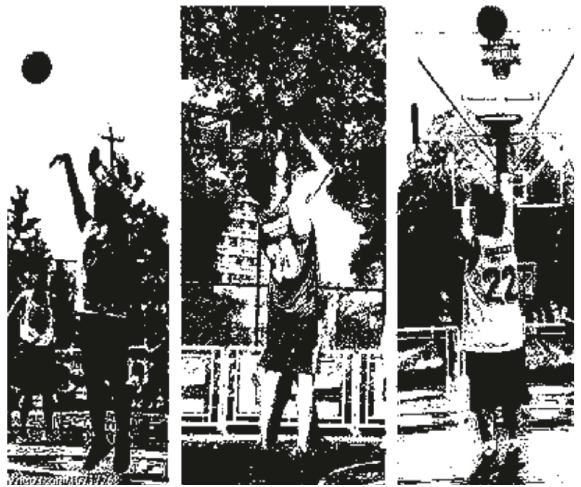
Figure 2: Image processing results.